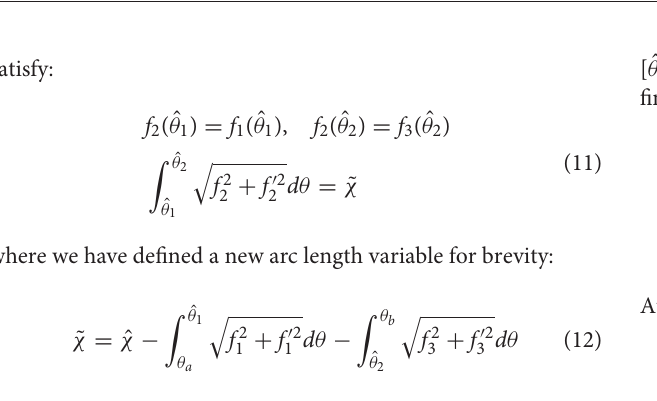
FIGURE 4 | ˆ E 1 , ˆ E 2 , and ˆ E 3 computed over midnight local time in the case of K p = 7. Bright colors indicate lower energy, and darker colors indicate higher energy. ˆ E 1 is shown in the top left panel, ˆ E 2 in the top right, and ˆ E 3 in the bottom left. In the bottom right panel, the region where this method should be applied is shown in